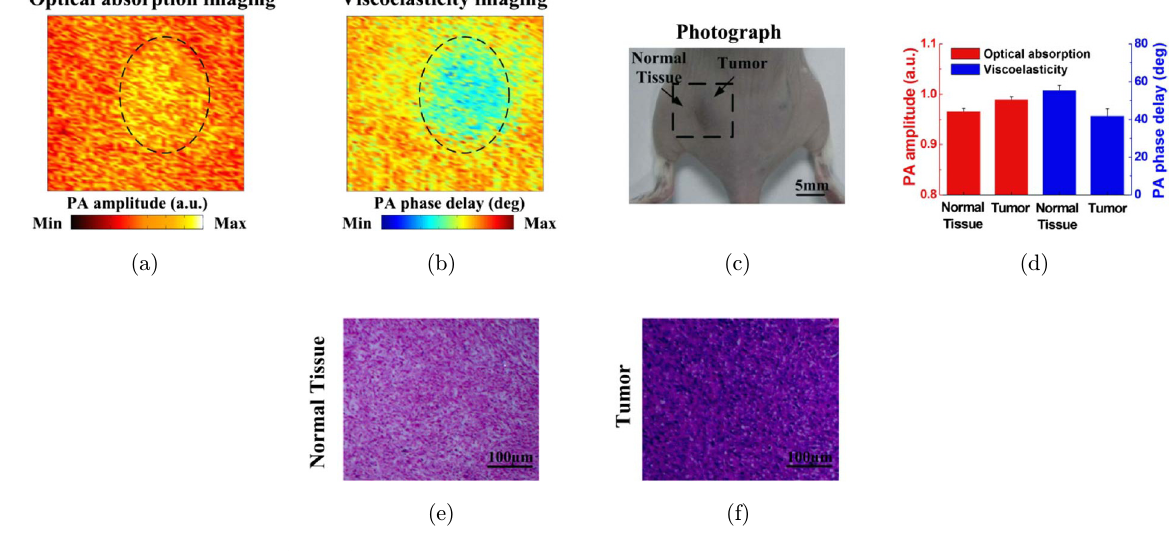
Fig. 5. (a) Optical absorption image and (b) viscoelasticity image of the tumor. (c) Photograph of the tumor and the dashed frame is the scanning area. (d) The averaged amplitude and phase delay of the PA signal from the marked tumor region compared to the normal tissue. (e), (f) Hematoxylin – eosin stains of the normal tissue and tumor